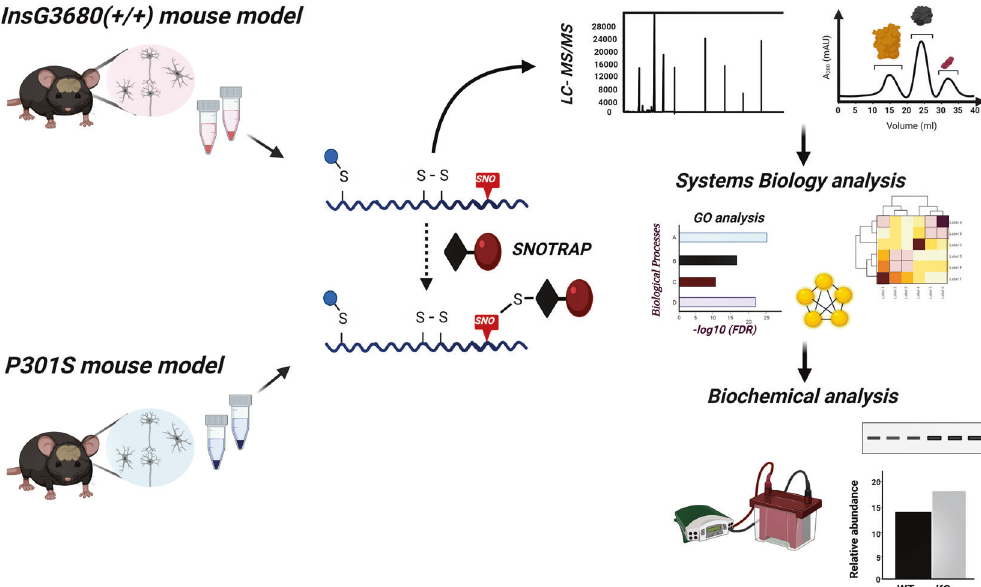
Fig. 1 Schematic work fl ow of the study. Schematic work fl ow of the SNOTRAP-based MS analysis of the ASD and AD cortex samples followed by large-scale systems analysis and biochemical